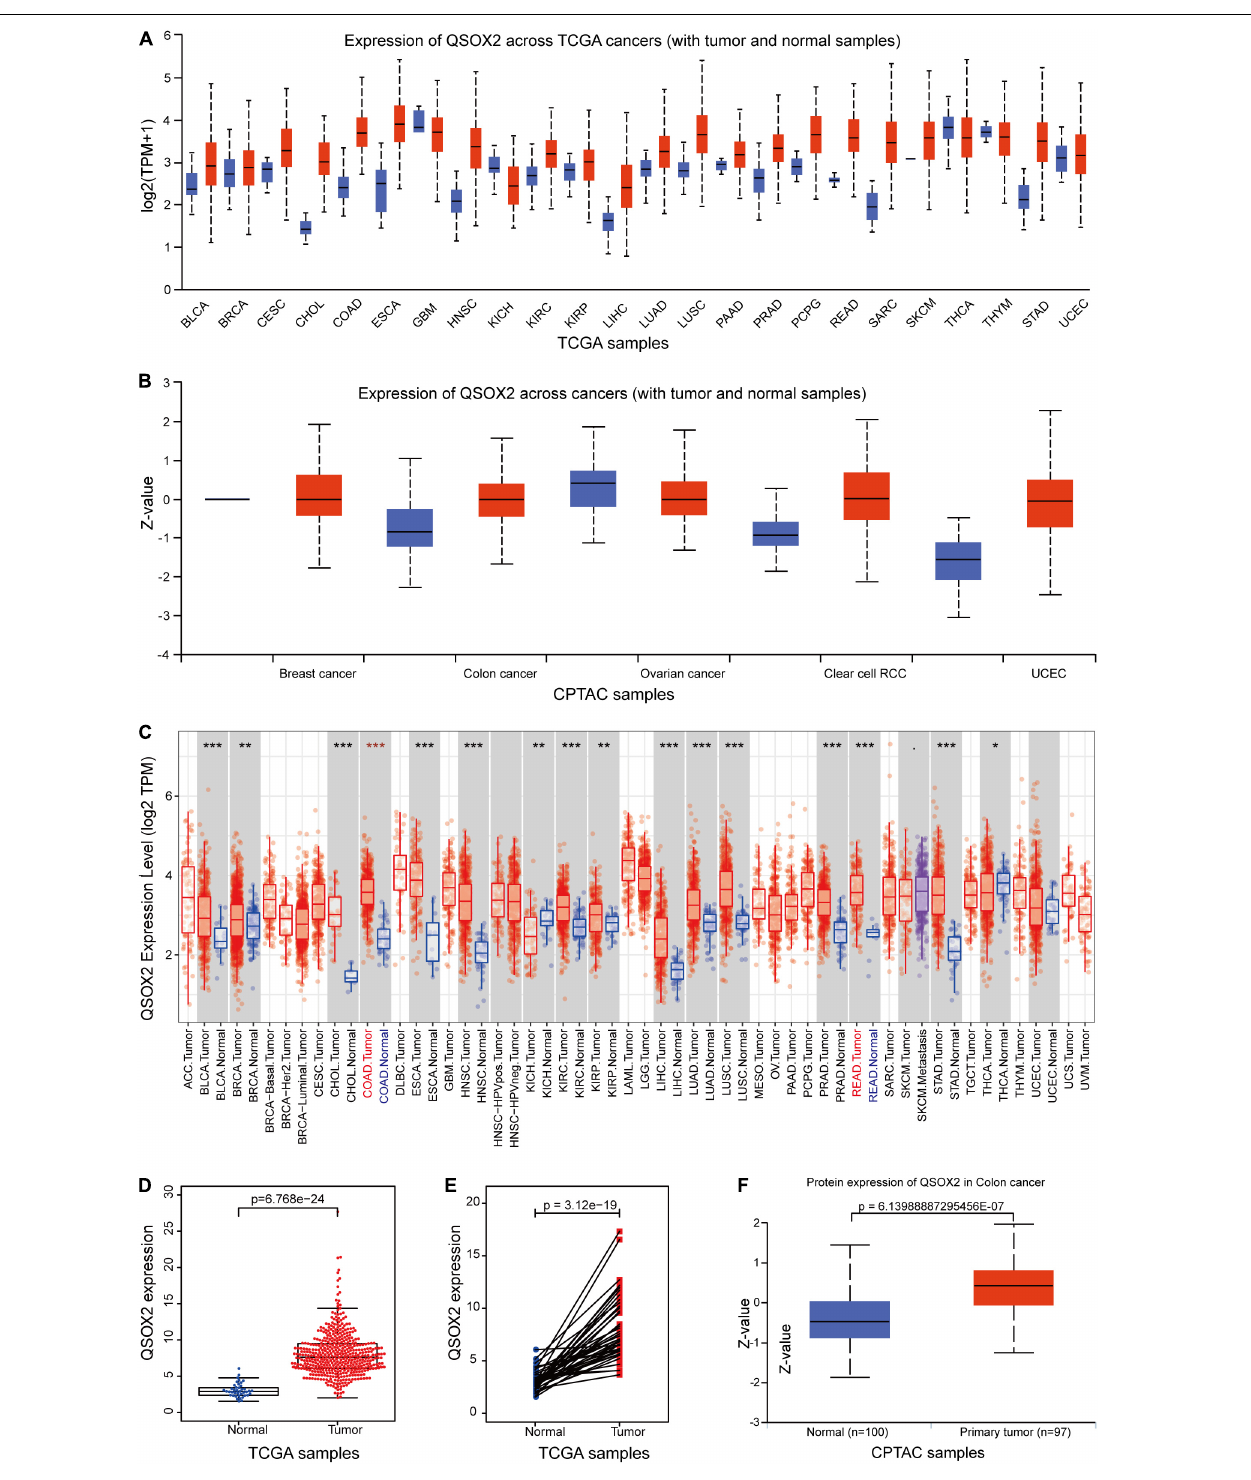
FIGURE 1 | Quiescin sulfhydryl oxidase 2 (QSOX2) expression in pan-cancer and in colorectal cancer (CRC). (A,B) The QSOX2 expression of mRNA level in multiple human cancers and corresponding normal tissues in the UALCAN database. (C) The QSOX2 expression of mRNA level in different human cancers and corresponding normal tissues in the TIMER database (* p < 0.05; ** p < 0.01; *** p < 0.001). (D) The QSOX2 expression of mRNA level in CRC tumors and corresponding normal tissues from TCGA database. (E) QSOX2 mRNA expression in pairs of tumor and normal tissues of CRC patients from TCGA database. (F) QSOX2 protein expression in the primary tumors and normal tissues of CRC patients from CPTAC database.